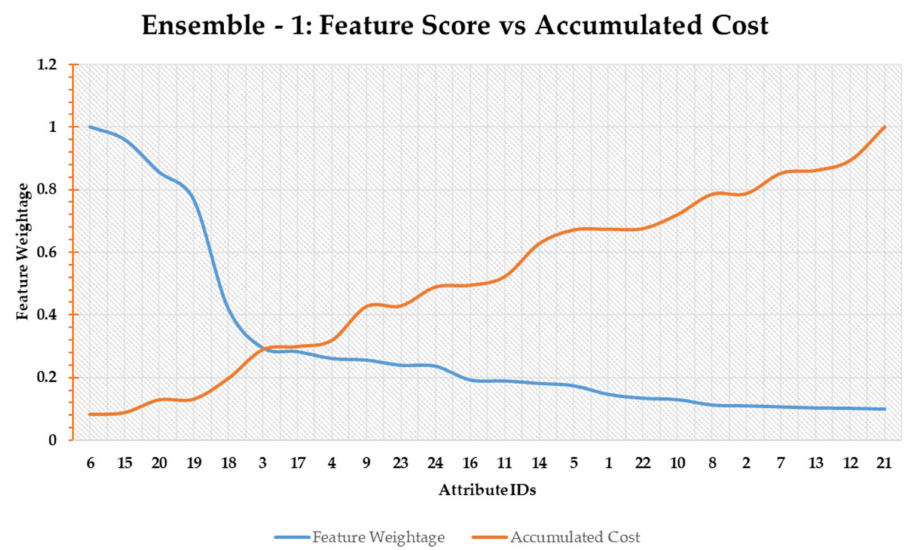
Figure 10. Ensemble-1 based feature scoring.